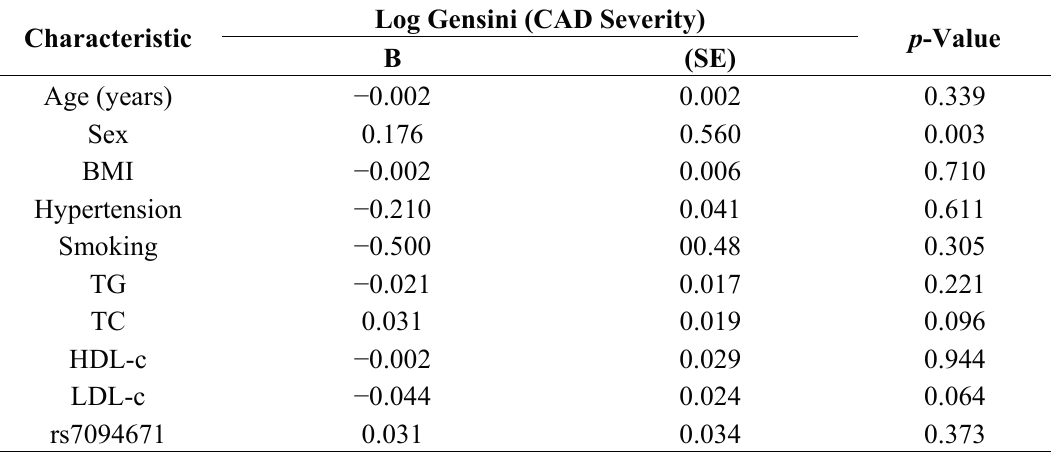
Table 4. Multivariate predictors of CAD